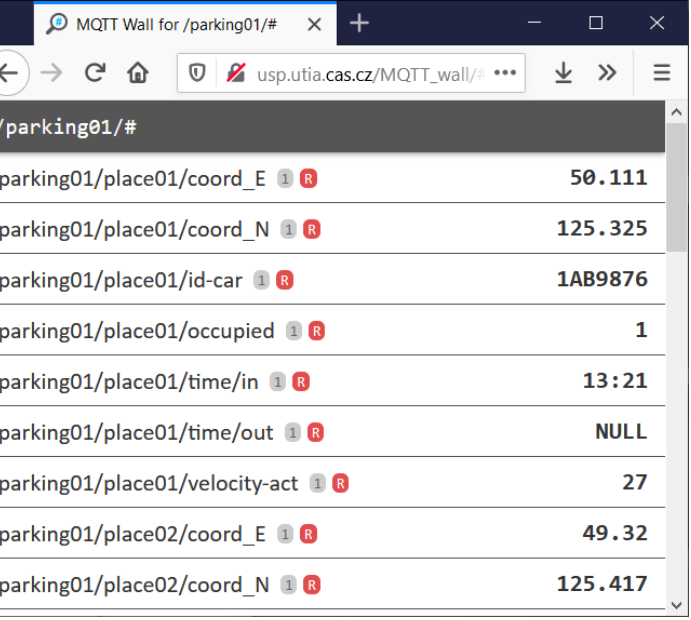
Figure 3. Output from the MQTT wall monitoring